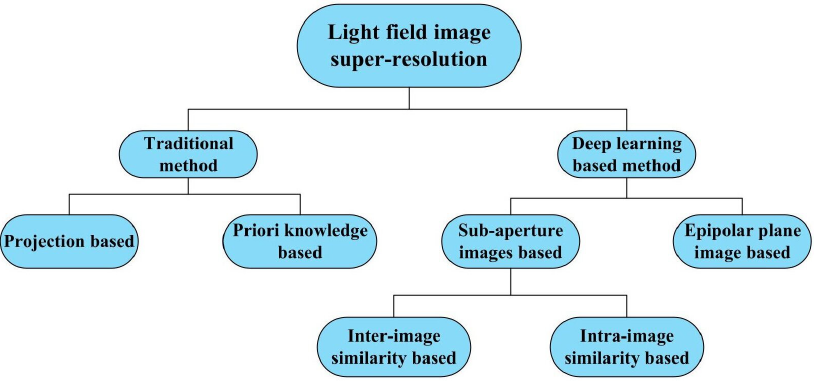
Figure 3. Classification of light field image super-resolution methods in this review.